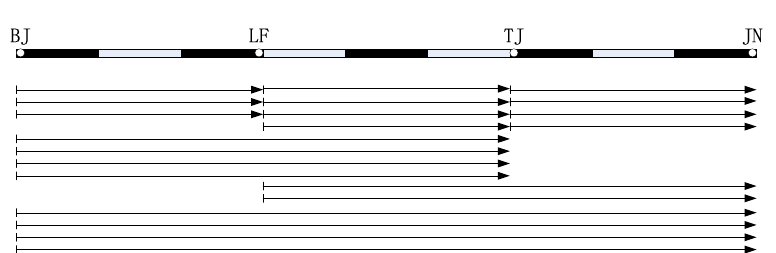
Figure 5. Line plan of BJ station-JN station in high-speed